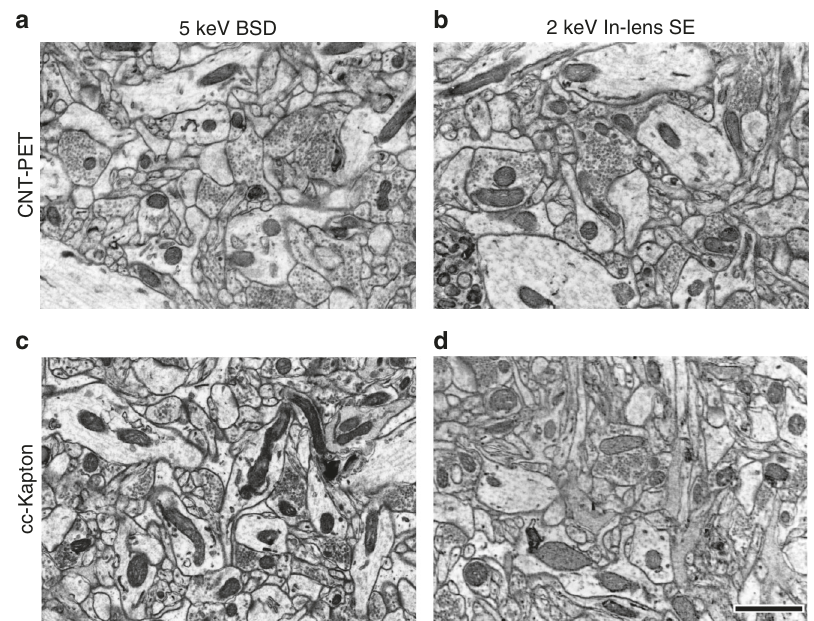
Fig. 2 Images of ultrathin sections on CNT-PET tape and cc-Kapton tape are comparable. a – d , Images of mHMS-treated brain tissue captured with the BSD at 5 keV, 3.2 µ s dwell time ( a , c ) or the In-lens SE detector at 2 keV, 3.2 µ s dwell time ( b , d ) on CNT-coated PET tape ( a , b ) or on cc-Kapton tape ( c , d ). Scale in d , 1 µ m, is also for a –